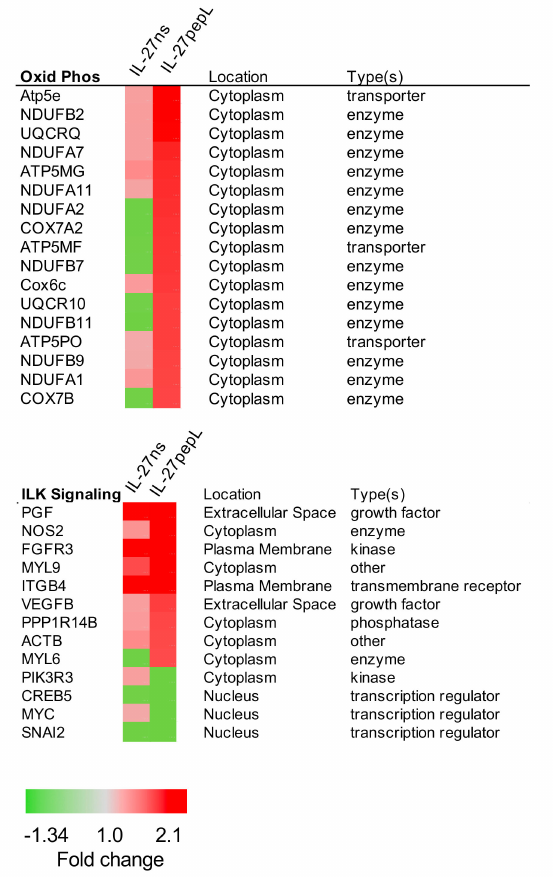
Figure 6. Top canonical pathways that di ff ered between IL-27pepL and controls. This figure shows the two novel signaling pathways for signaling promoted by IL-27pepL, including oxidative phosphorylation (top) and ILK signaling (bottom). Color bar: fold